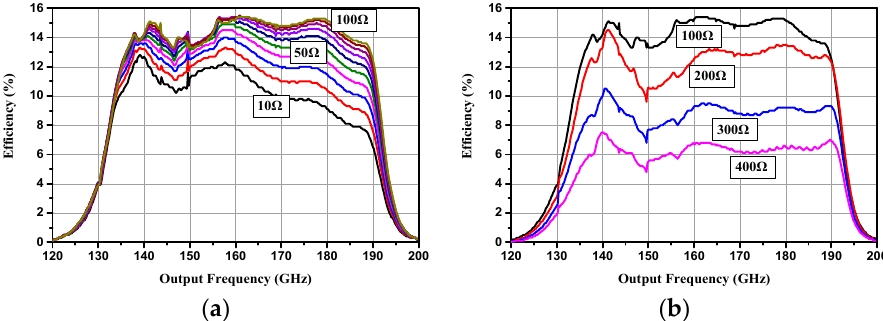
Figure 7. Simulated efficiency under different self-bias resistors ( a ) from 10 to 100 Ω ; ( b ) from 100 to 400 Ω .